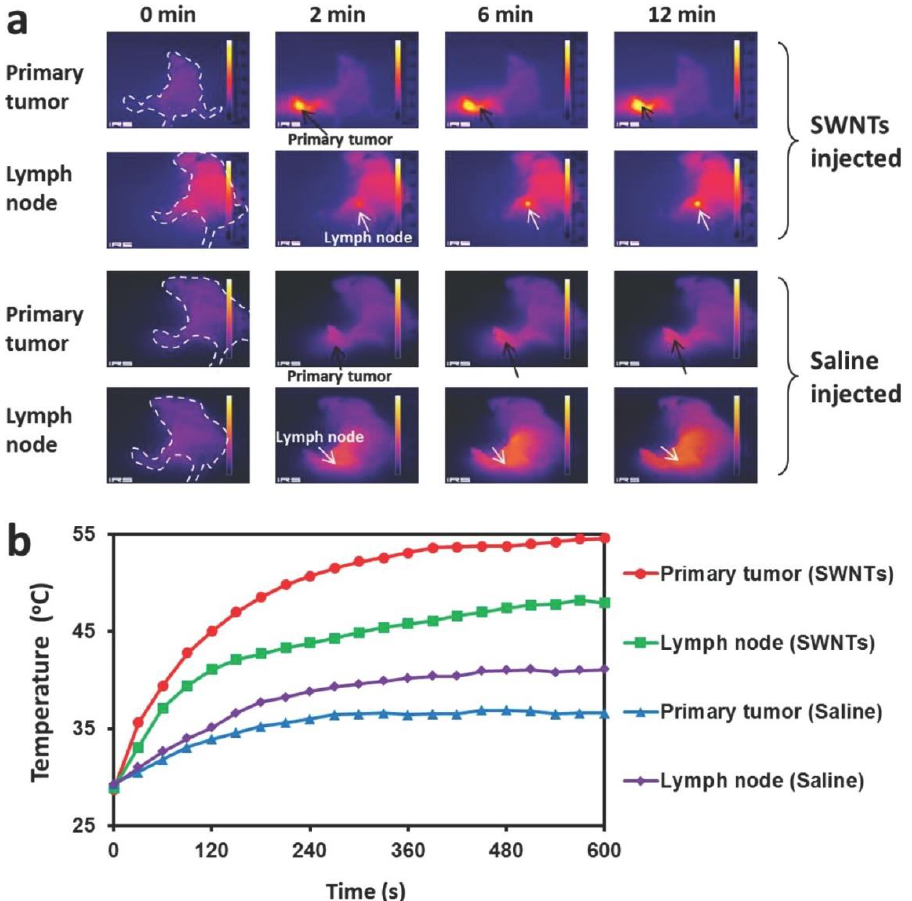
Figure 2. In-vivo photothermal heating. ( a ) IR thermal images of 4T1 tumor-bearing mice with the primary tumor and the popliteal lymph node separately exposed to the NIR laser at different power densities of 0.5 W cm −2 and 0.8 W cm −2 , respectively. The heating experiment was started 90 min after injection of SWCNT–PEG or PBS into the primary tumor. The primary tumors and lymph nodes are pointed out by black and white arrows, respectively. The dose of SWCNTs was ca. 0.2 mg kg −1 . ( b ) Temperature elevation on the primary tumor and the lymph node monitored by an IR thermal camera during laser irradiation as shown in ( a ). SWCNT injection resulted in rapid temperature rises of both the primary tumor and the popliteal sentinel lymph node. Reprinted with permission from [41], Wiley, 2014.